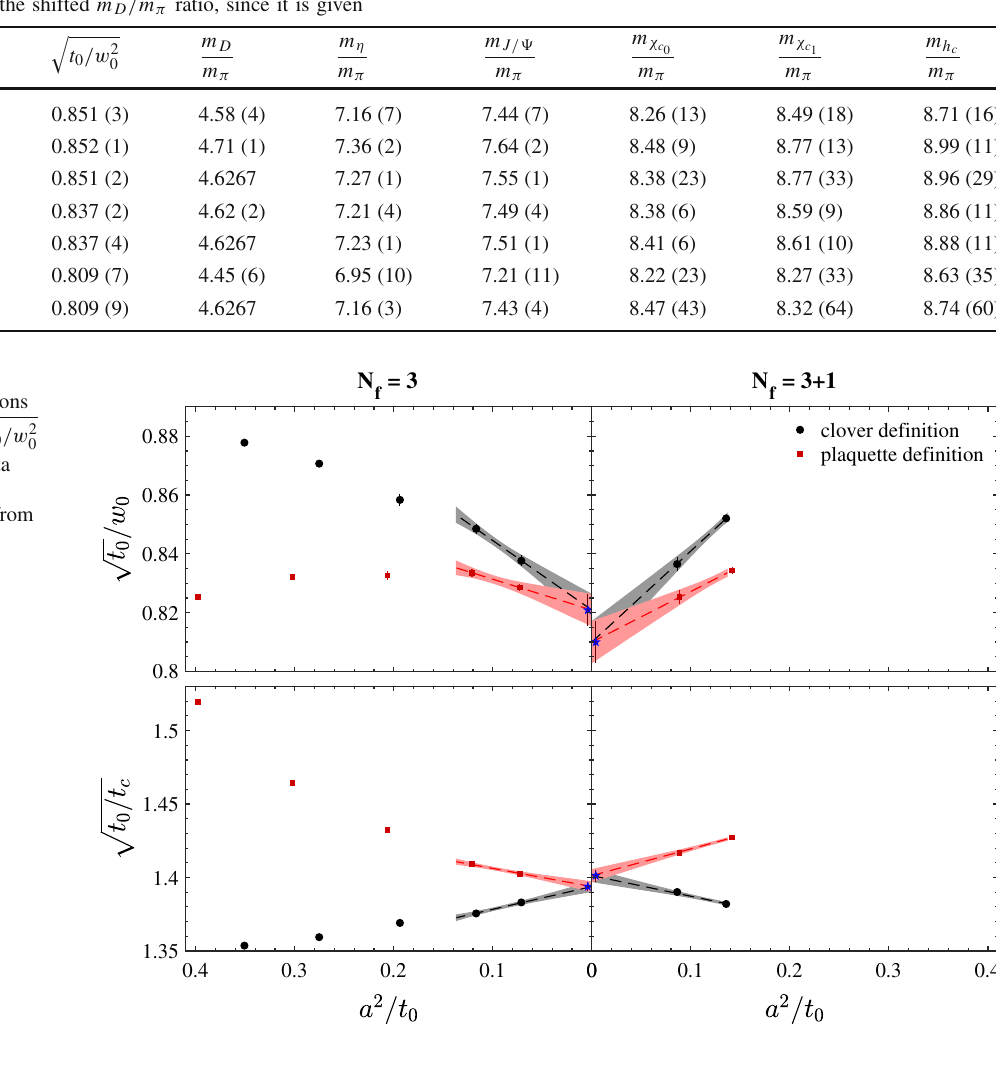
√ 6 φ 4 . The last two lines correspond to contin- by the exact ratio of φ 5 / uum limit extrapolations of original and shifted values via linear fits of corresponding values from ensembles A2 and B